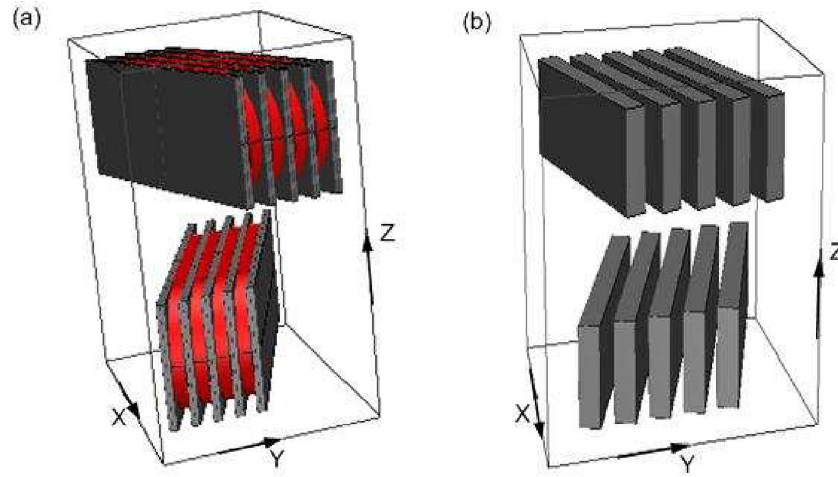
FIG. 4. (Color) Three-dimensional views of the elliptically polarized undulators ( (cid:6) (cid:1) 0 ) in (a) the racetrack coil structure (whose whole iron yoke was machined into many grooves for coil winding, with an angle (cid:6) between the transverse direction of the iron yoke and the groove) and (b) the staggered structure.